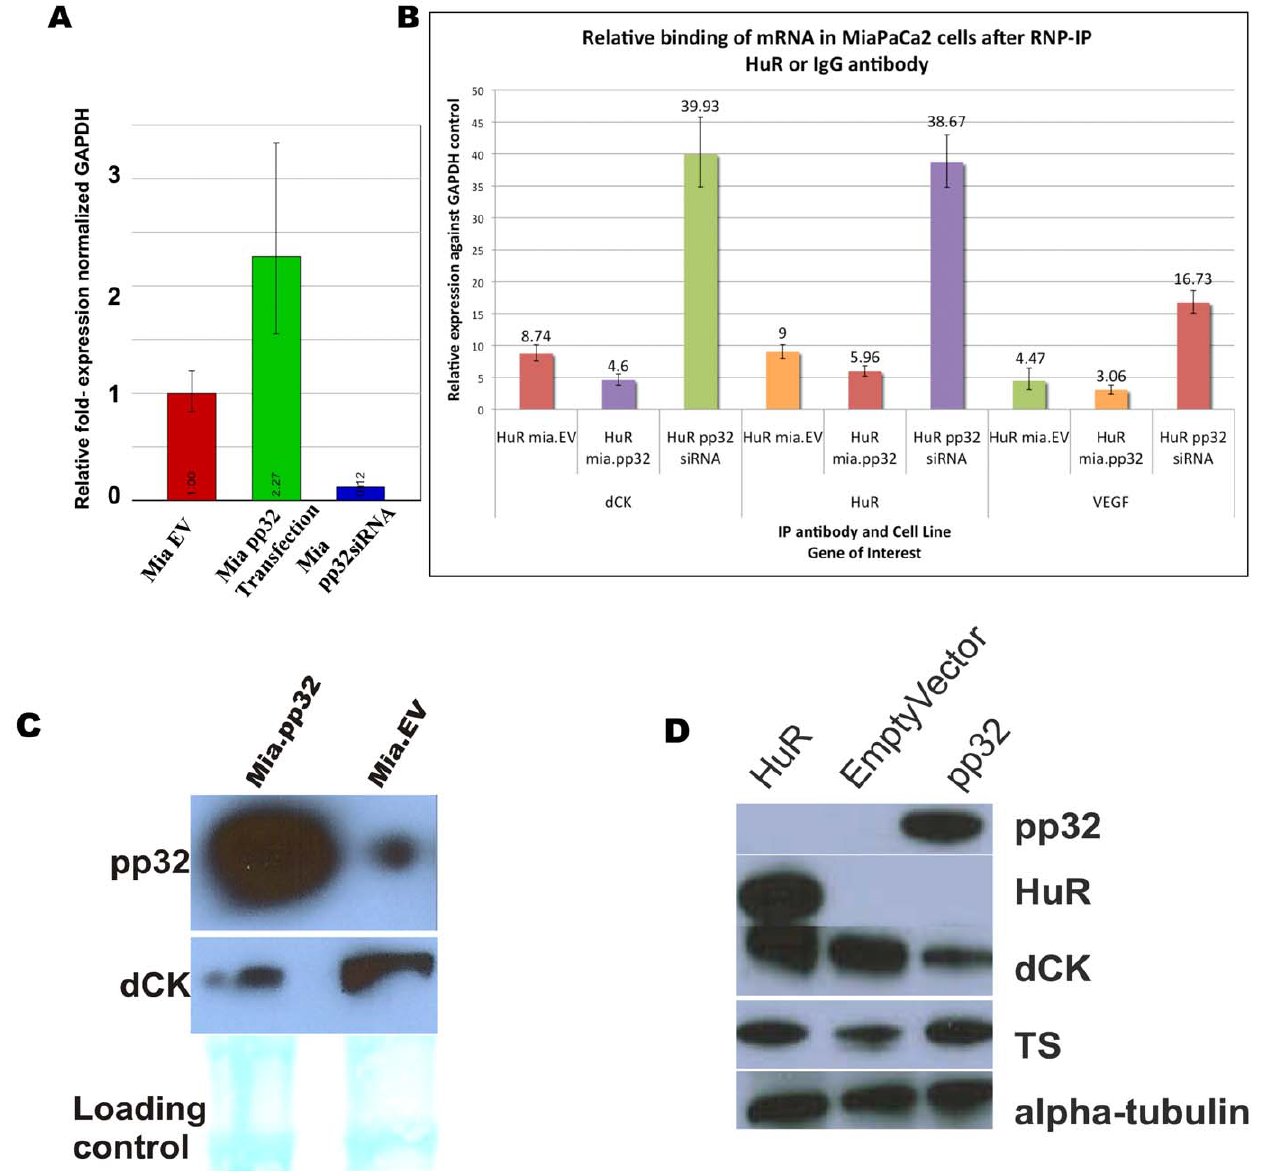
Figure 4. pp32 expression disrupts the association of HuR with dCK, HuR, and VEGF mRNAs. (A) pp32 mRNA levels normalized to GAPDH mRNA levels in empty-vector transfected cells, pp32 siRNA transfected cells, and pp32 plasmid transfected cells. Number indicates fold change of pp32 mRNA expression of labeled generated cell lines compared to empty vector control cells. (B) HuR binding to VEGF and dCK mRNAs was detected by RNP-IP analysis in MiaPaCa2 cells transfected with pp32 siRNA, pp32 plasmid, or empty vector control (A). mRNA levels in HuR and IgG IP samples were first normalized to GAPDH mRNA levels in the same IP reactions, and then plotted as relative fold enrichment in VEGF, dCK, and HuR mRNAs in HuR IP vs IgG IP. Data show the mean from 3 independent data points. Two independent experiments were performed in order to confirm the results. Numbers indicate fold changes compared to IgG control. (C) Western blot analysis of pp32 and dCK expression levels in protein lysates from Mia.pp32 and Mia.EV cells. (D) Three lanes represent lysates from HEK293T cells generated that either left to right: overexpress HuR, empty vector, or pp32 tagged with myc/DCK. Western blot analysis included antibodies recognizing pp32, HuR, dCK, alpha-tubulin, and thymidylate synthase (TS)